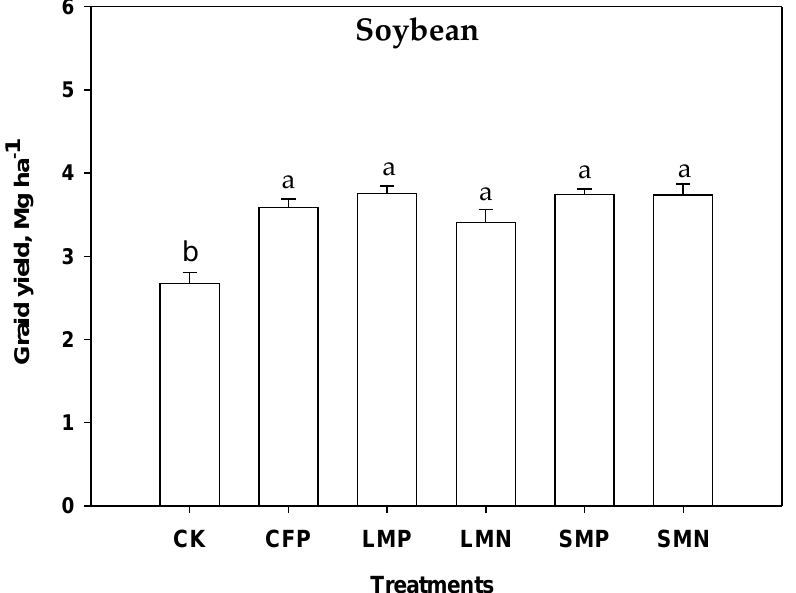
Figure 3. Responses of soybean grain yield to various sources of P addition (chemical fertilizer vs. liquid and solid swine manures) and application approaches (P-based vs. N-based) over a 10-year time period, 2004–2013, in a clay loam soil, Woodslee, ON, Canada. CK, no-P control; CFP, chemical fertilizer P; LMP, P-based liquid swine addition; LMN, N-based liquid swine manure addition; SMP, P-based solid swine manure addition; SMN, N-based solid swine manure addition. Error bar is the standard error of the mean (n = 15). The different letters over the bars indicate significant differences at the p ≤ 0.05 level.